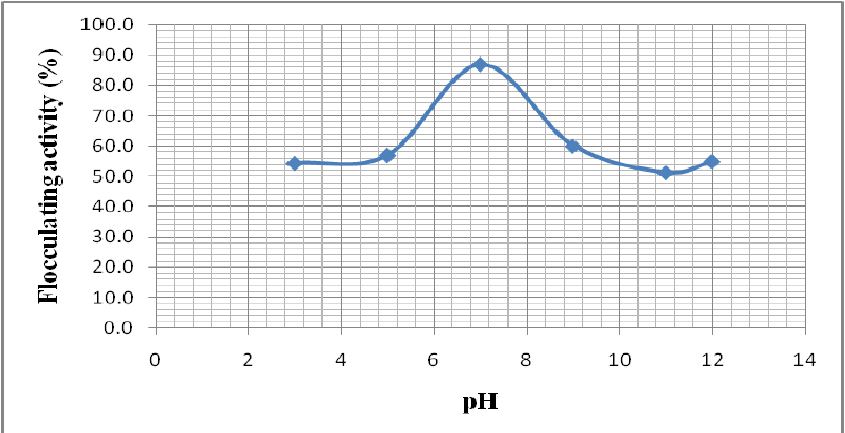
Figure 6. Effect of pH on flocculating